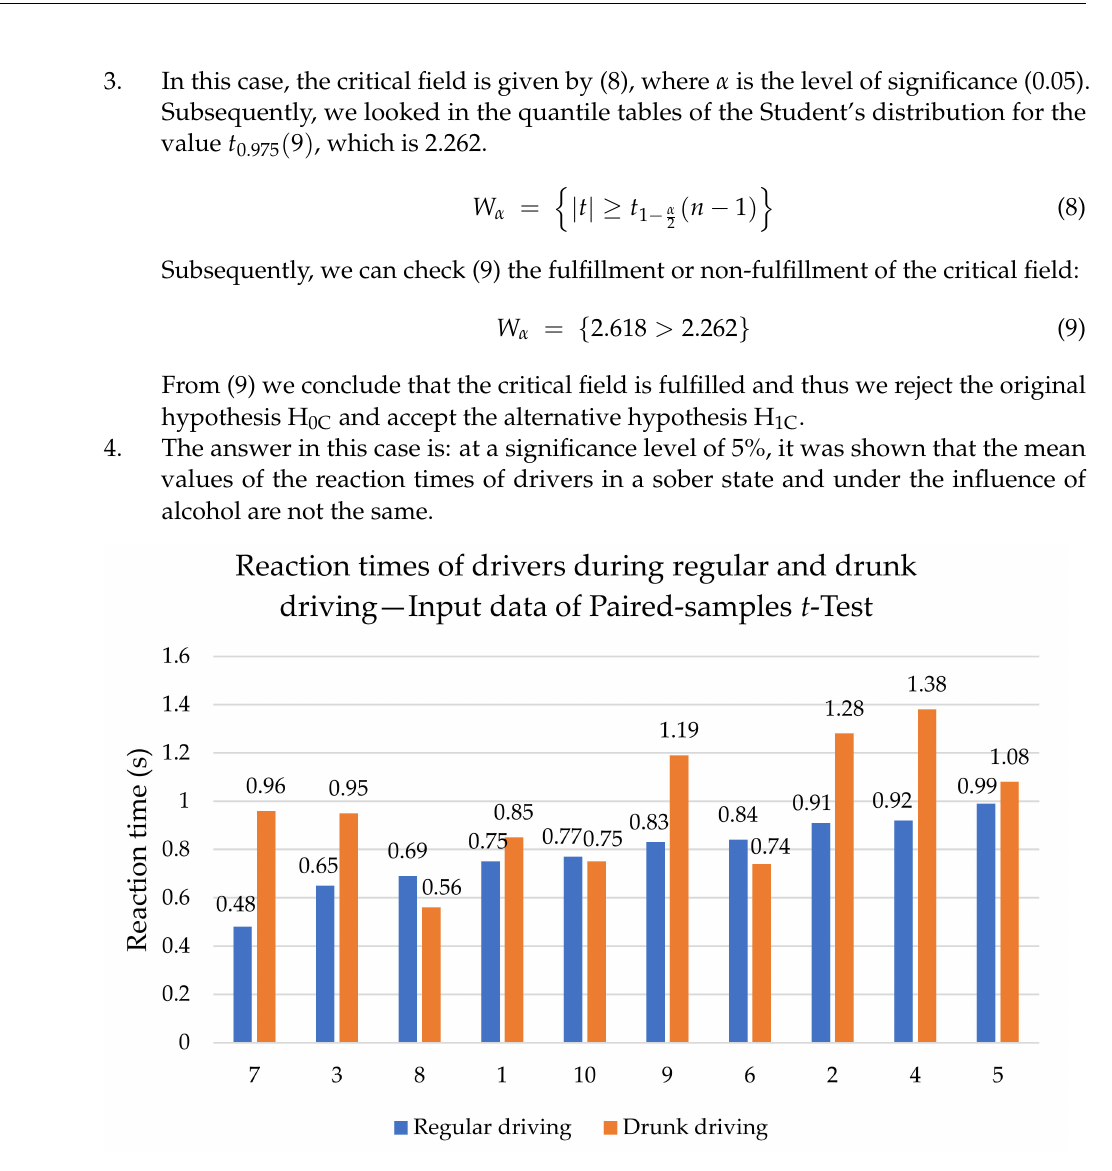
Figure 5. Input data of paired-samples t -test. Source: Processed by